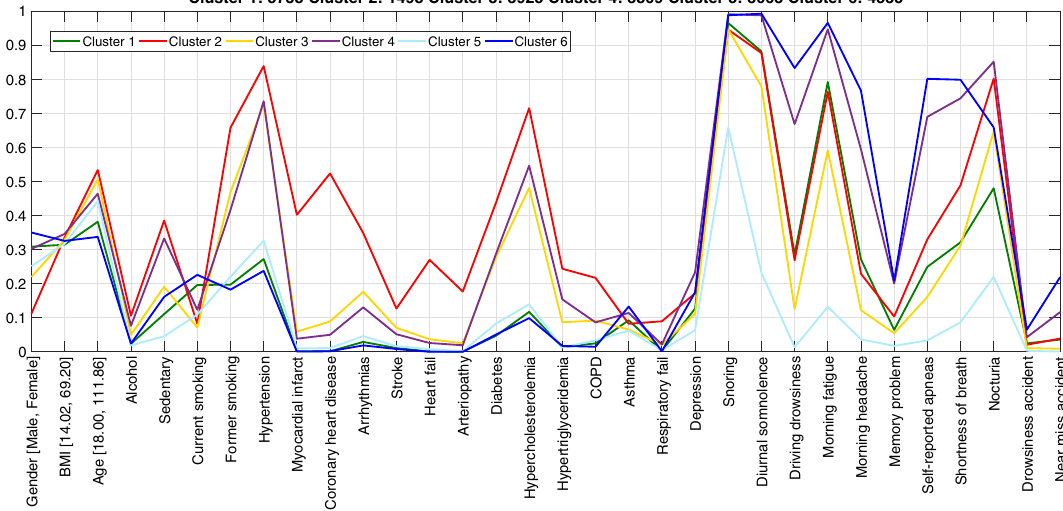
Fig. 16 The centers of clusters at time 0. The y -coord shows the per- centage of patients in a group with a specific symptom (from Snoring to Near miss accident) or comorbidity (from hypertension to depres-